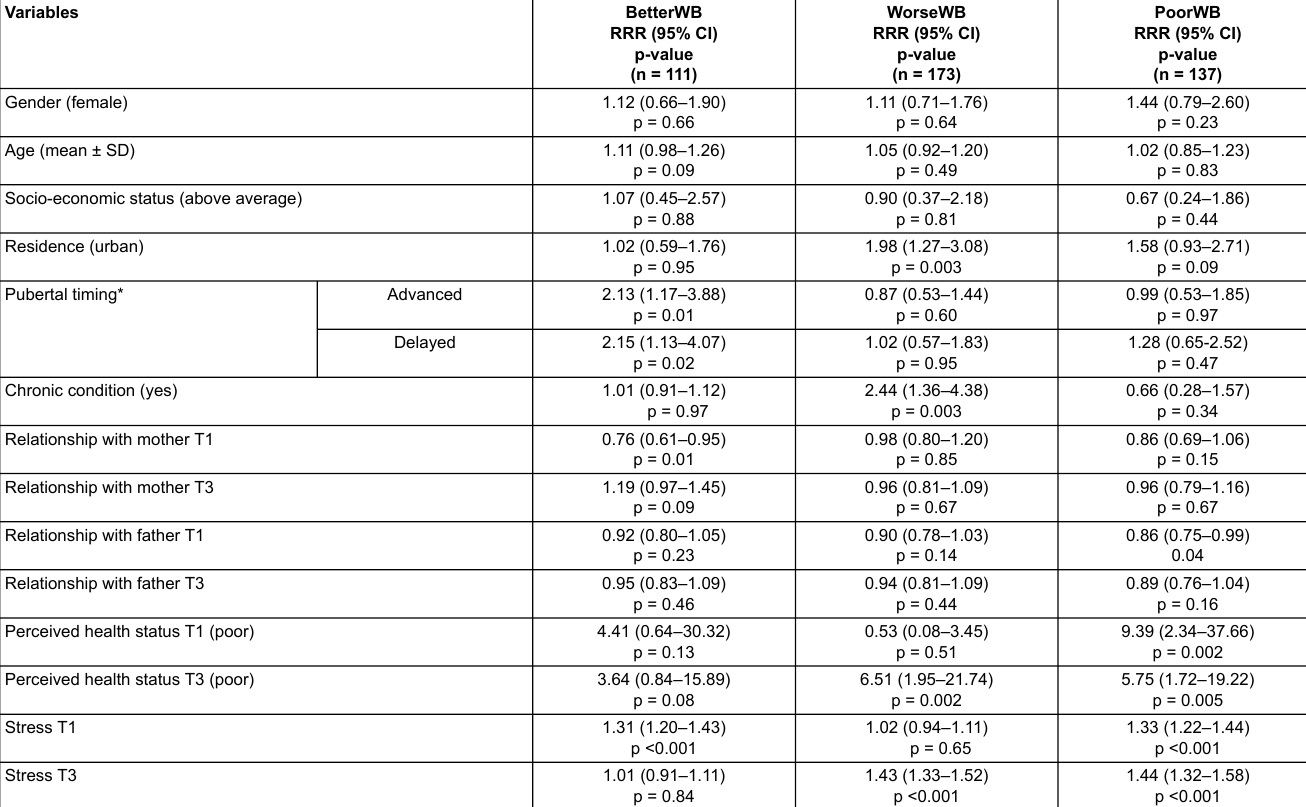
Table 2: Regression analysis comparing the four study